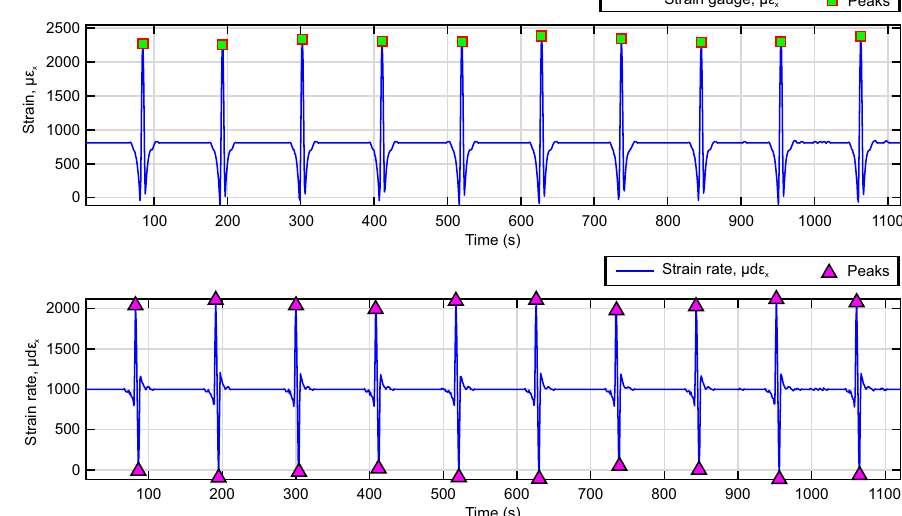
Figure 5. Selection of the deformation characteristics in the time history of the deformation in the circumferential direction ( ε x ), and its derivative curve ( d ε x ) Operating conditions: 0.8 bar , 0 ◦ , 50 km/h, 500